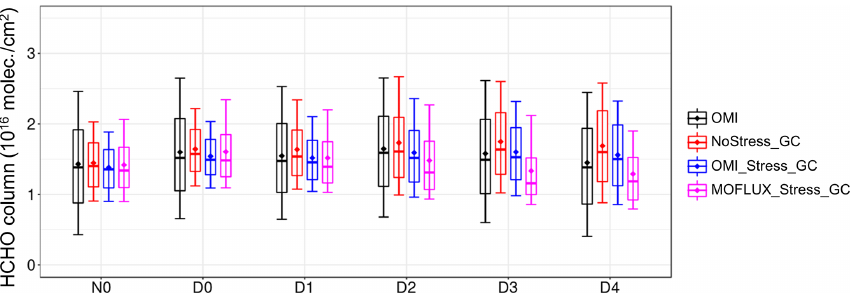
Figure 8. Boxplot of HCHO column statistical distributions for OMI observations (black) and different GEOS-Chem simulations: without drought stress (NoStress_GC; red) and with drought stress factors derived from MOFLUX observations (MOFLUX_Stress_GC; blue) and from OMI HCHO constraints (OMI_Stress_GC;